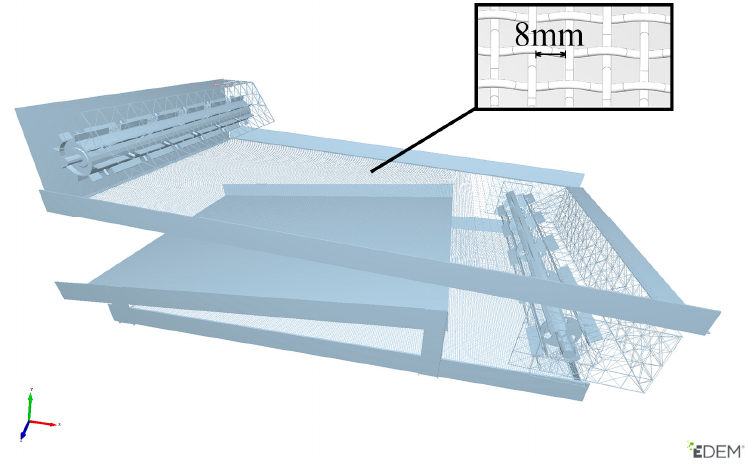
Figure 6. 3D model of the device inside the EDEM.